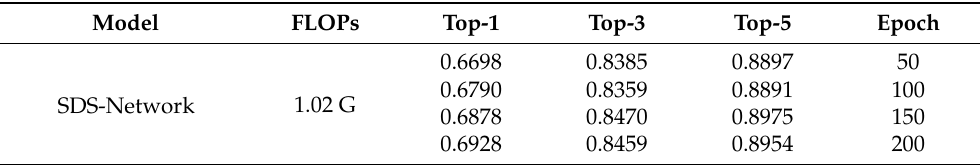
Table 9. SDS-Network data sheet in Cifar-100.